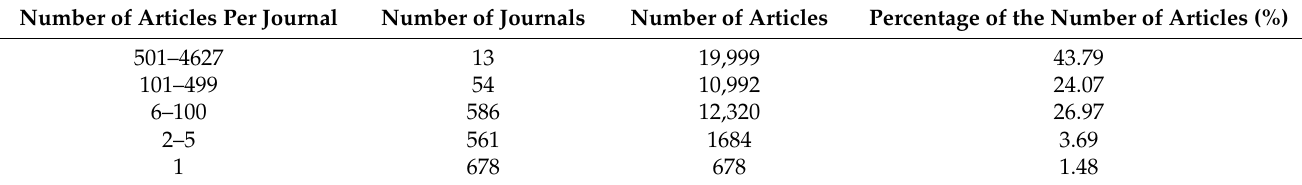
Table 1. Classification of journals by the number of articles referencing EO